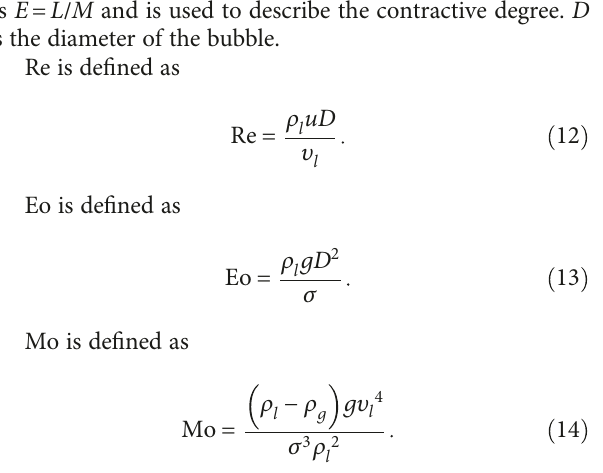
Figure 1: Physical model.